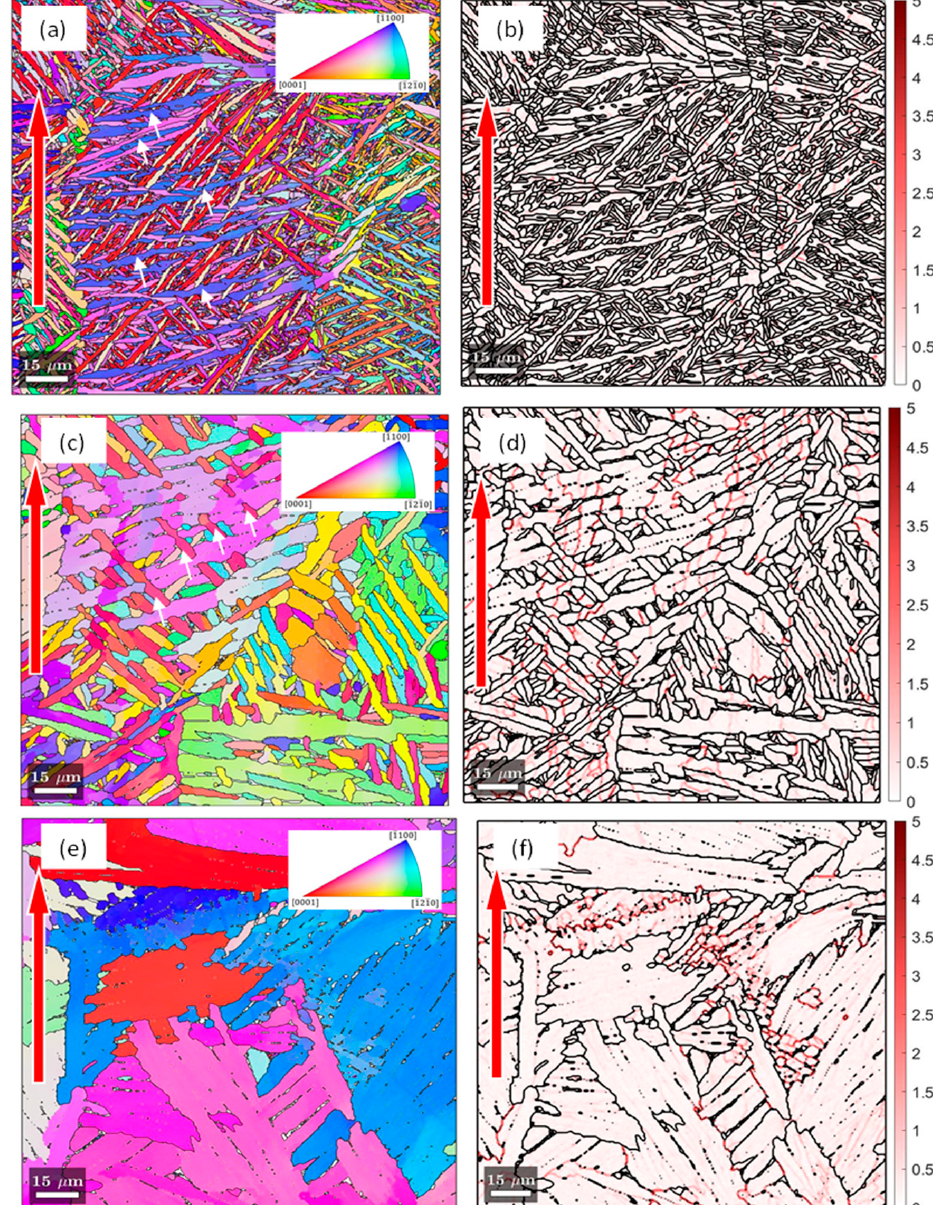
Figure 5. ( a , c , e ) The orientation distribution maps and ( b , d , f ) the local grain misorientation/low angle grain boundary maps in samples C, D and E, respectively. The red arrows indicate the build orientation.